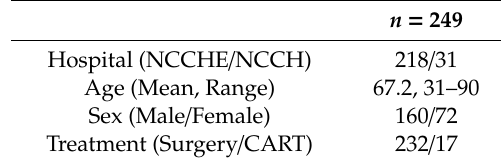
Table 1. Patient Characteristics of all study participants (includes surgical cases).